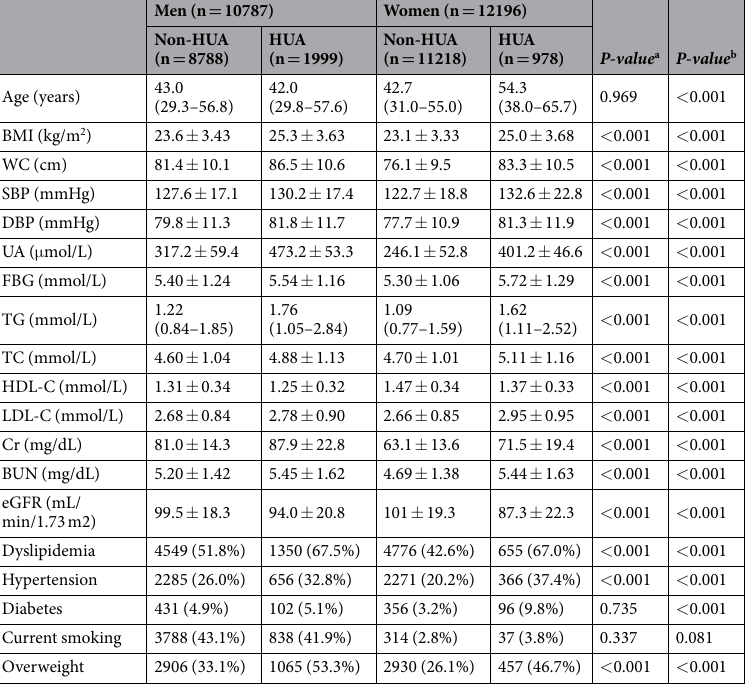
Table 2. The characteristics of the study participants. Data are presented as mean ± standard deviation (SD), n (%); Age and TG were reported as medians (interquartile range). HUA, hyperuricemia; BMI, body mass index; WC, waist circumference; SBP, systolic blood pressure; DBP, diastolic blood pressure; UA, uric acid; FBG, fasting blood glucose; TG, triglyceride; TC, total cholesterol; HDL-C, high density lipoprotein cholesterol; LDL- C, low density lipoprotein cholesterol; Cr, creatinine; BUN, blood urea nitrogen; eGFR, estimated glomerular filtration rate. a Non-HUA vs. HUA in men; b Non-HUA vs. HUA in women.